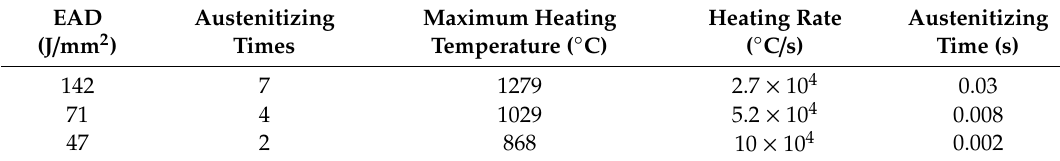
Table 4. Specific parameters of the thermal cycle process.